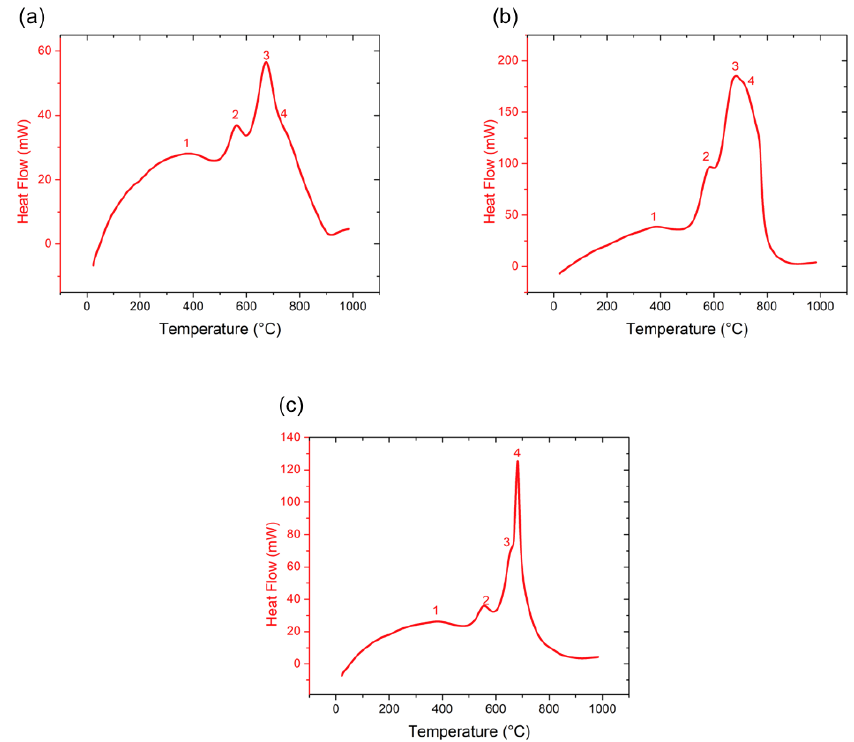
Figure 11. Heat-flow exotherms of the CNT fibers that were previously annealed at ( a ) 300 °C, ( b ) 500 °C, and ( c ) 700 °C, showing the four exotherms of interest here.